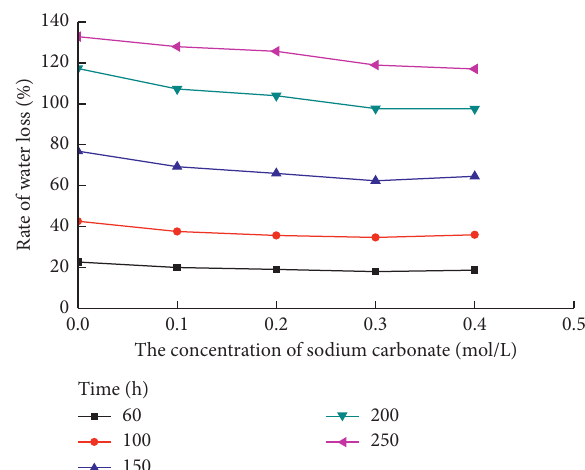
Figure 8: Relationship between the sodium carbonate concen- tration and the water loss.